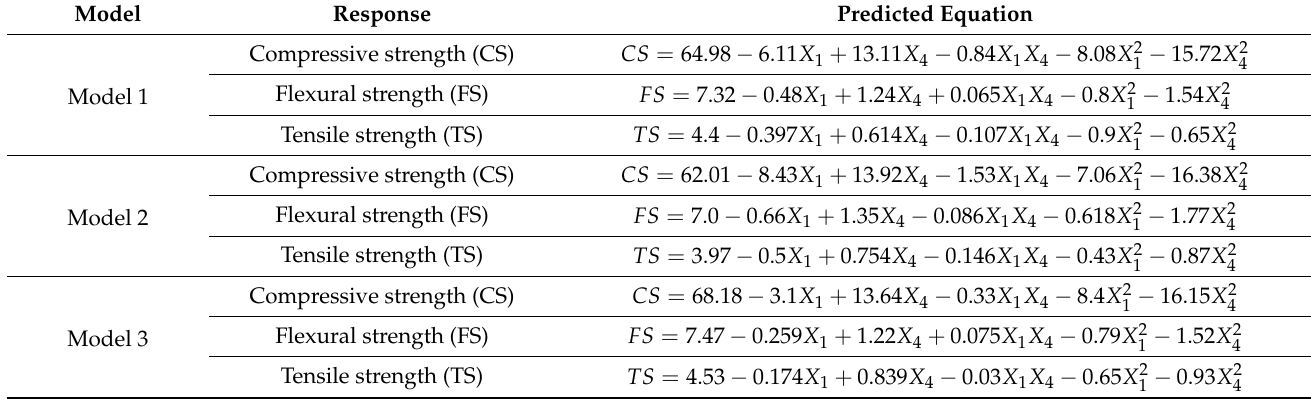
Table 3. Predicted equations of compressive, tensile, and flexural strength for all